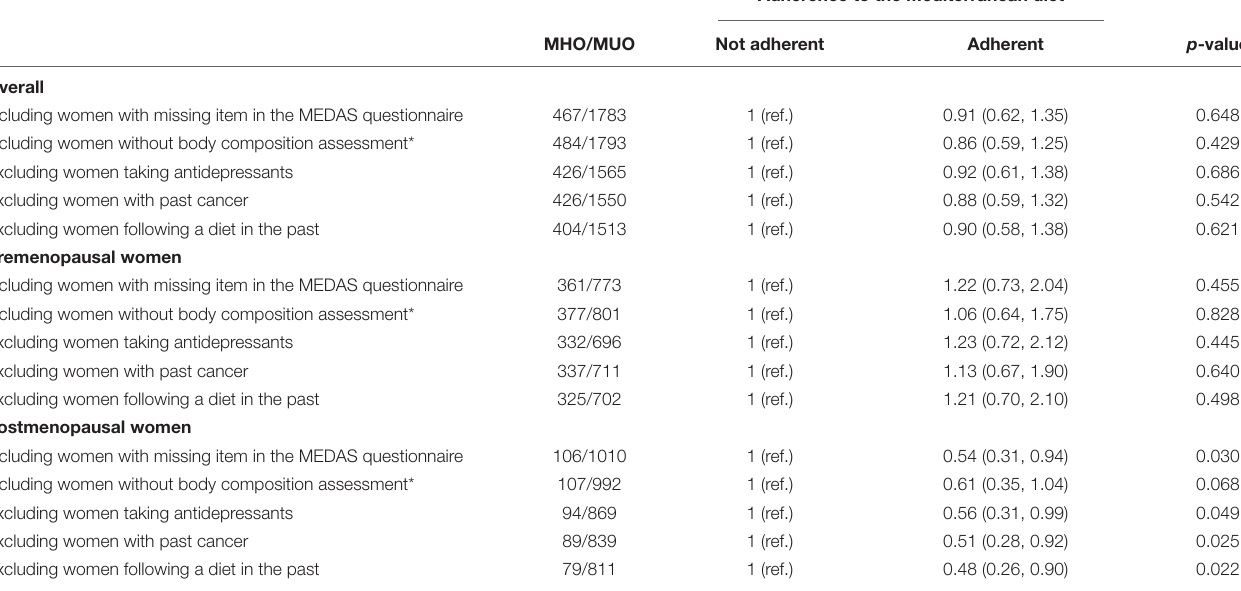
TABLE 5 | Sensitivity